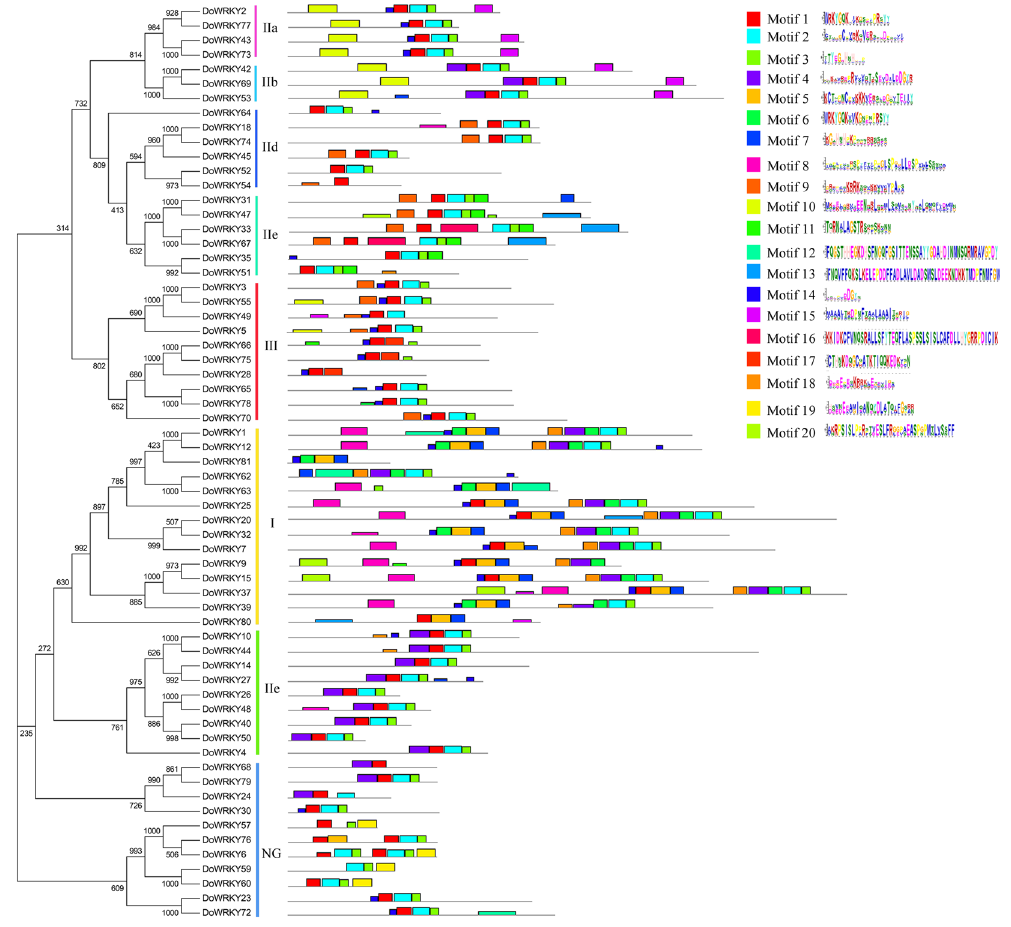
Figure 2. Visualization of the classification of DoWRKY proteins and the distribution of 20 predicted motifs in these proteins. The phylogenetic tree was inferred using the Neighbor–Joining method and 1000 bootstrap replicates with full-length of DoWRKY amino acid sequences by ClustalX 2.0 software. The conserved motifs were investigated by the MEME